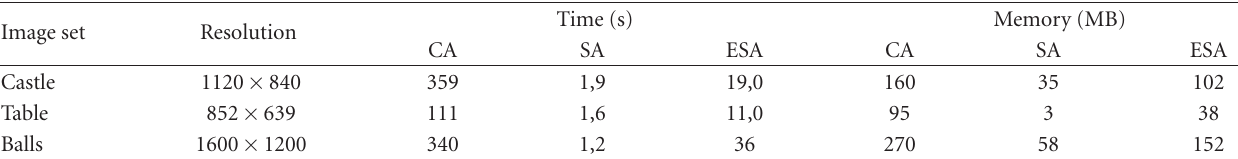
Table 1: Basic characteristics of the three algorithms applied to the tested images. Image